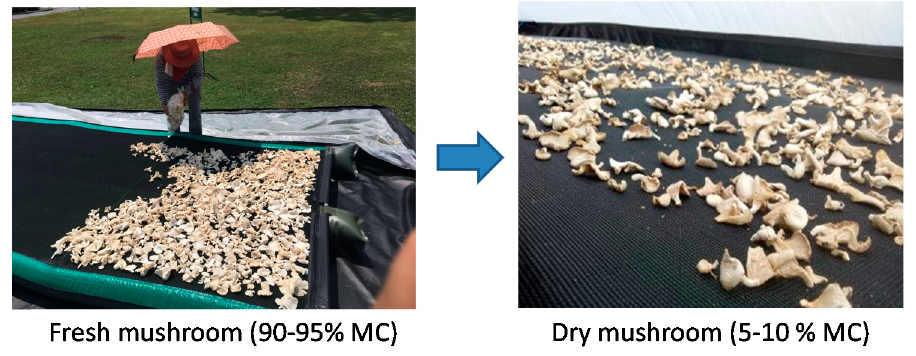
Figure 6. Fresh and dry oyster mushrooms before and after drying.